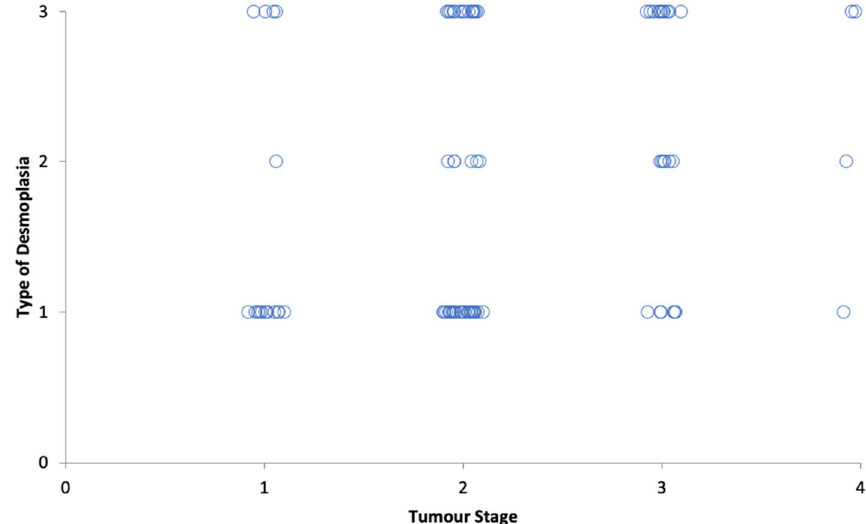
Fig. 4 Scatter plot showing correlation between tumor stage and stromal desmoplastic